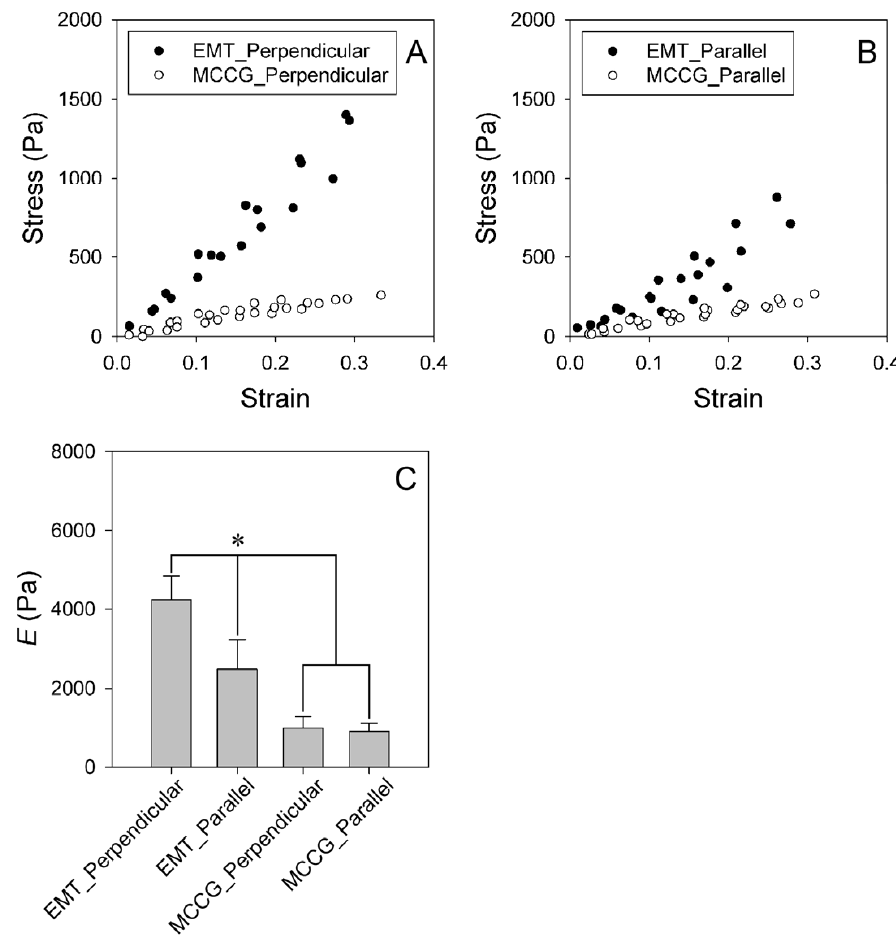
Figure 5. ( A , B ) Stress–strain curves of the EMT and MCCG in the perpendicular and parallel directions. All measured data ( n = 4) are shown; ( C ) comparison of elastic moduli of the EMT and MCCG. Error bars indicate standard deviation ( n = 4). The asterisk indicates significant differences of p < 0.05. Comparison performed by using ANOVA test and post hoc Tukey’s test.